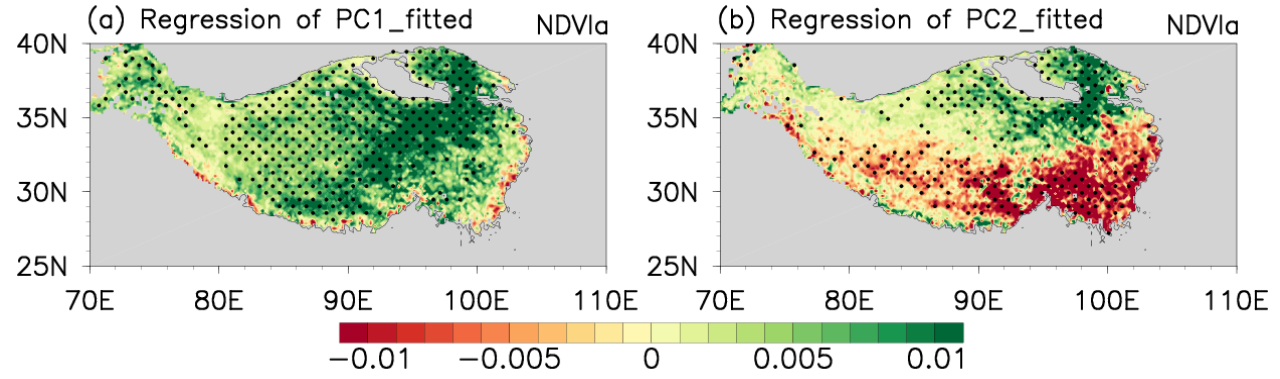
Figure 4. JJAS TP NDVI anomalies regressed upon PC1 ( a ) and PC2 ( b ) for the period 1982–2020, in which the NDVI anomalies significant at the 95% confidence level are stippled with black dots.